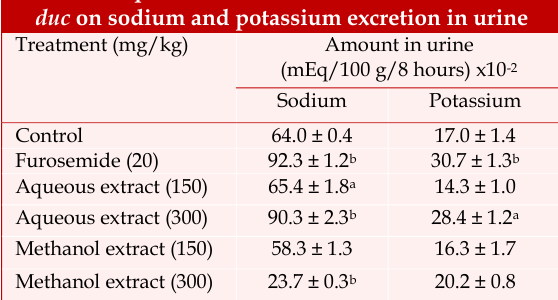
Effect of aqueous and methanol extracts of C. bon- duc on sodium and potassium excretion in